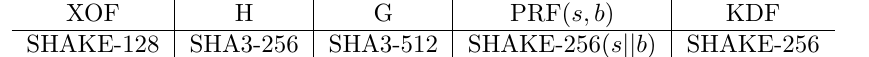
Table 7: Instantiation of different symmetric primitives from the FIPS-202 standard XOF